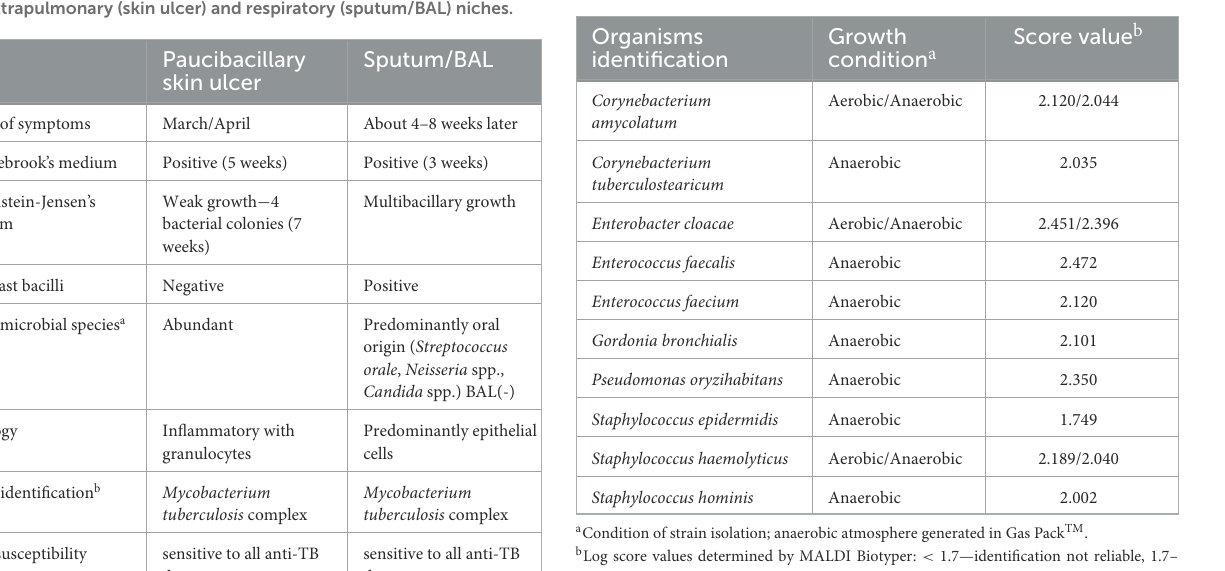
TABLE 2 Non-mycobacterial microbiota isolated from a necrotizing